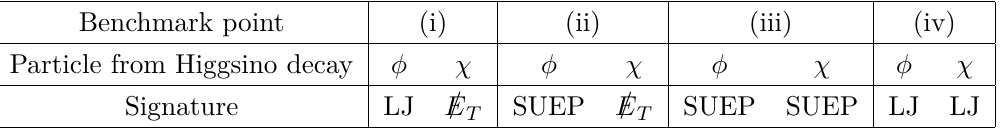
where θ is the mixing angle in the scalar sector (given by eq. (3.15) in NMSSM), hφ